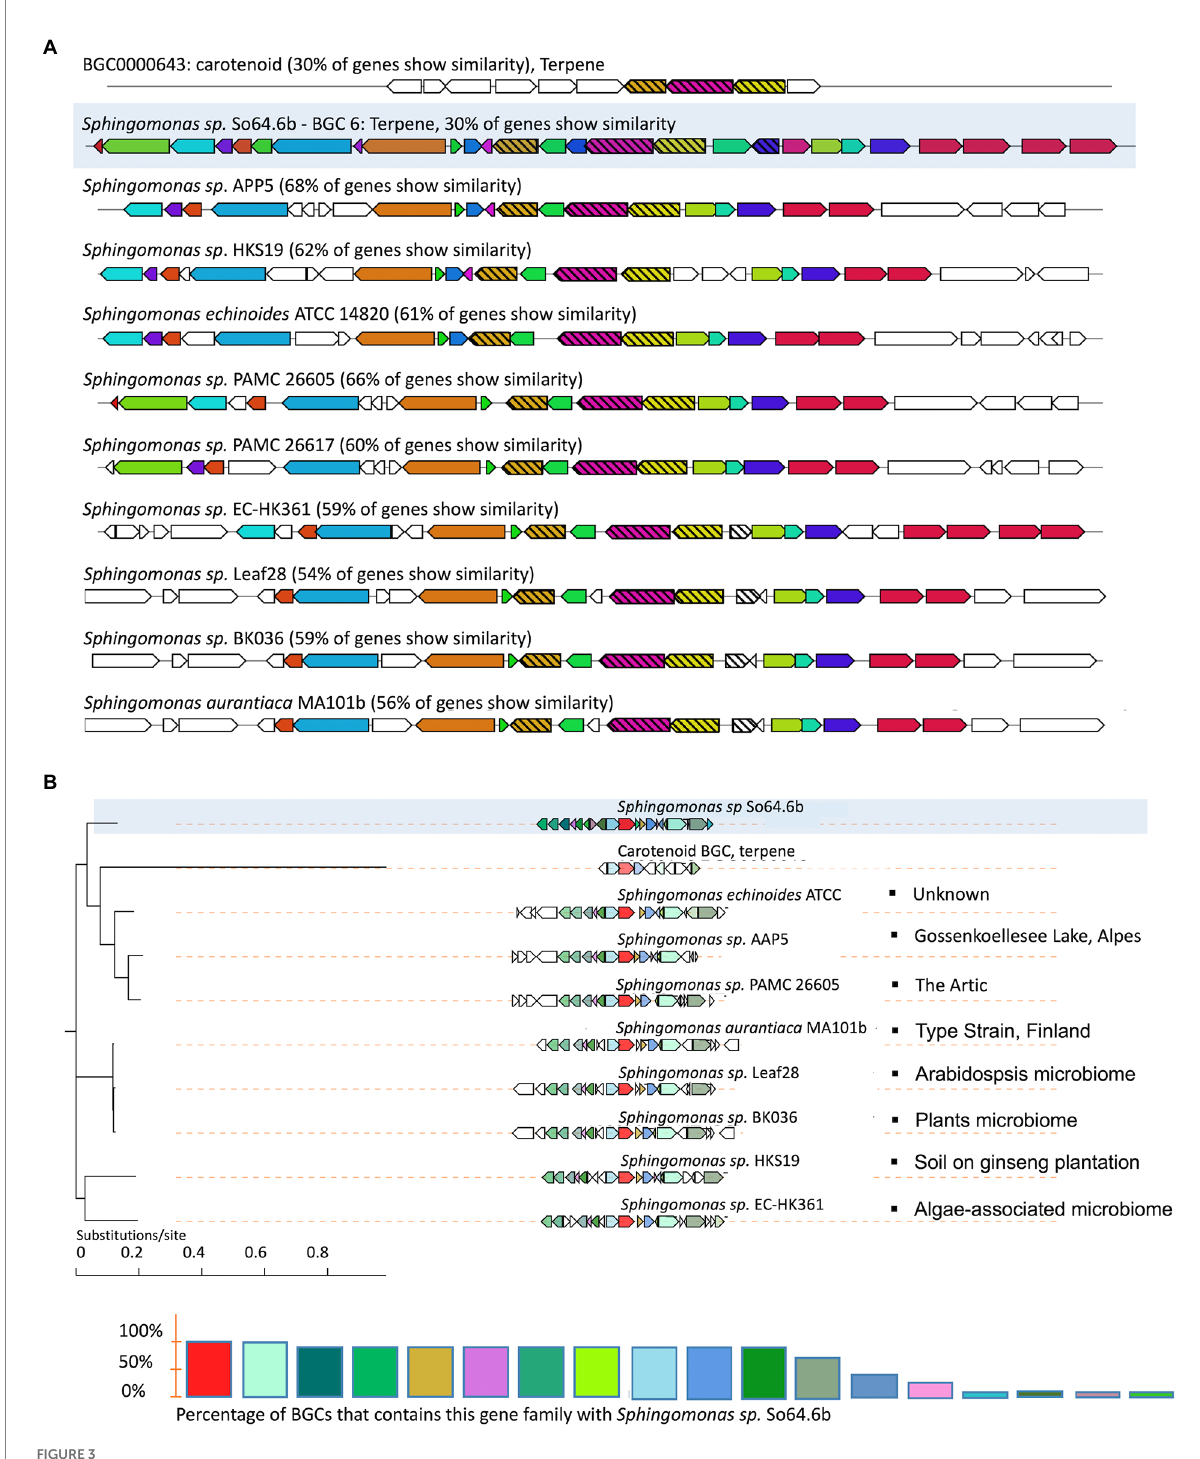
FIGURE 3 Variation in the genomic proximity of the terpene-like BGC-6 of the Antarctic strain So64.6b with similarity to the MiBIG reference BGC0000643 from Brevundimonas vesicularis (Tao et al., 2006). (A) Similarity plots of terpene BGCs from species of the genus Sphingomonas , including the Antarctic Sphingomonas sp . So64.6 (highlighted) and its closest species, mapped to the known carotenoid cluster BGC0000643 (on top). The colors match the shared genes, and those related with biosynthesis are shown in strip-pattern. (B) Terpene cluster phylogeny inferred by CORASON showing the frequency of occurrence of each gene family in comparison with the cluster from Antarctic strain So64.6b. Differences in sequence similarity are also indicated by a color gradient in the depicted gene blocks. The bullets at the end of each branch indicate the bacterial origin according to the metadata reported for the sample (Biosample data from NCBI